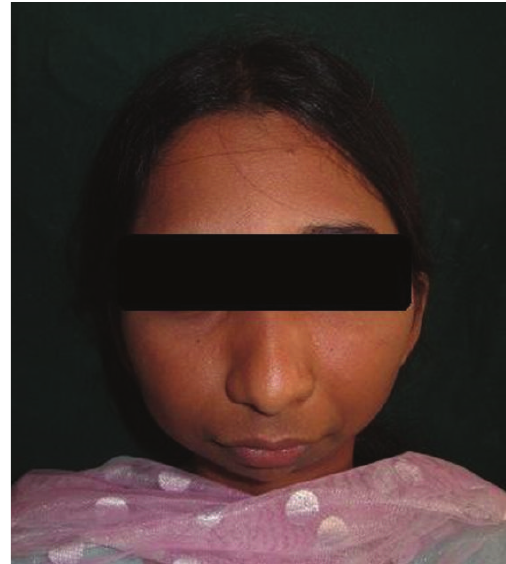
Figure 1: Frontal view of patient.